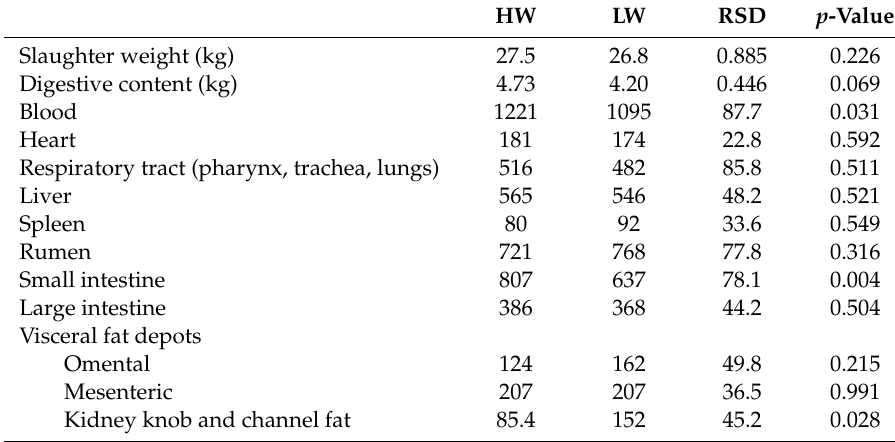
Table 2. Slaughter LBW (kg), digestive content (kg) and visceral organ weights (g) and fat depots (g) in lambs born with high (HW) or low weight (LW).